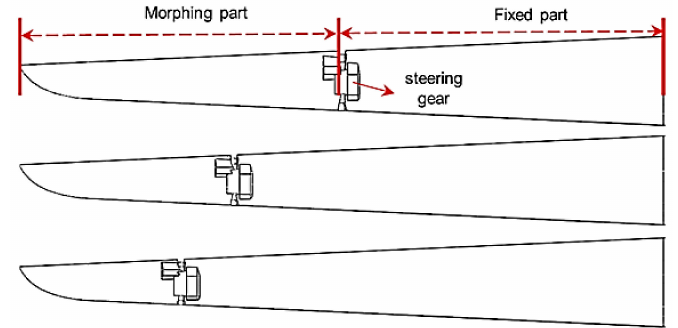
Figure 1. Comparison of three spanwise morphing wings.